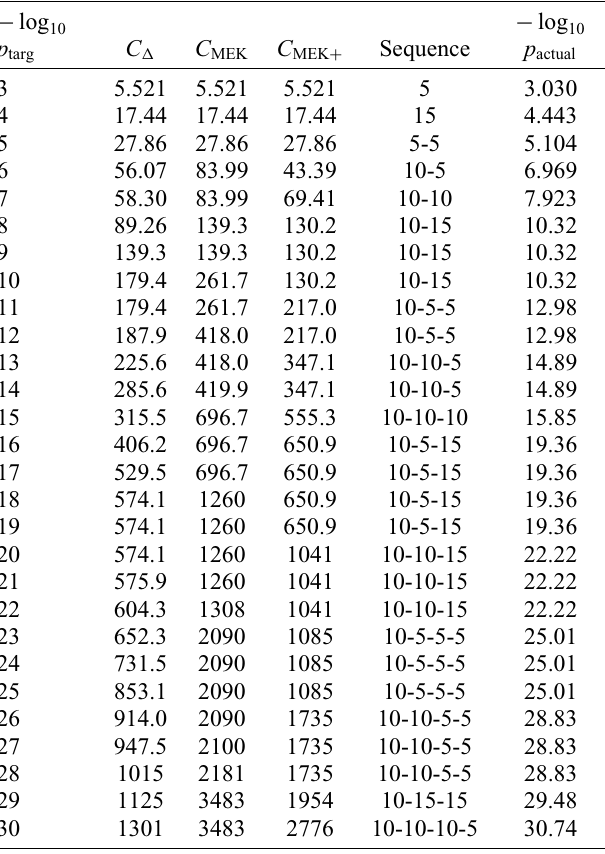
TABLE II. The distillation costs for various MSD protocols to achieve target error rates p targ , assuming an input error rate of p = 0.01. The MEK+ protocol ( C MEK + ) equals or betters the original MEK protocol [17] ( C MEK ) and betters the tri- The “Sequence” column shows the sequence of distillation proto- cols used in the MEK+ protocol, where 5 is 10-to-2, 10 is 10-to-1, and 15 is 15-to-1; p actual is the output error rate achieved by the sequence.